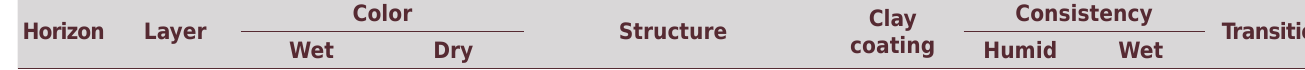
Table 1. Morphological properties of soils in a topographic sequence, São Vicente Férrer, Pernambuco, Brazil Color Consistency Clay Horizon Layer Structure Transition coating Wet